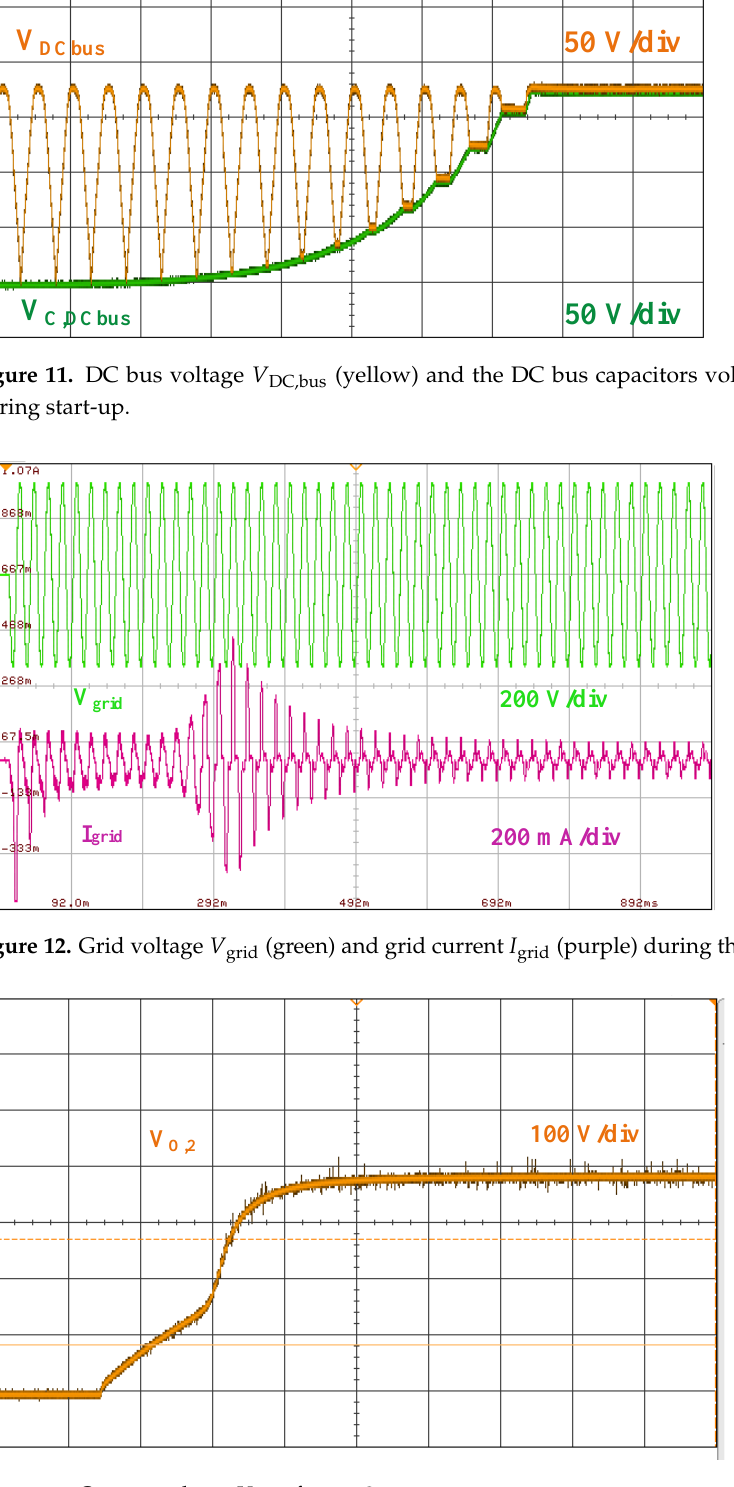
Figure 13. Output voltage V o,2 of stage 2.